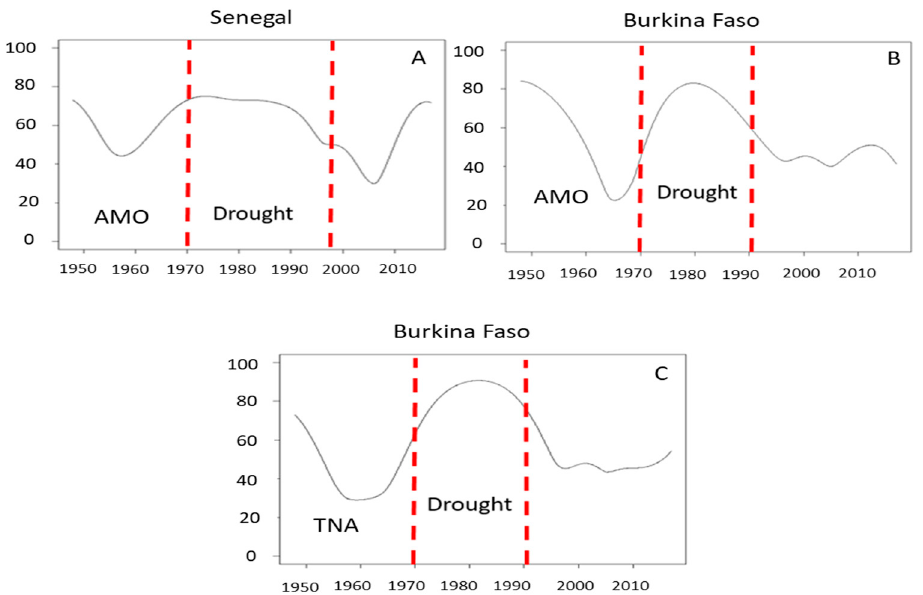
Figure 5. Percentage of consistency between precipitation and the AMO and TNA index for mode 8–16-years.